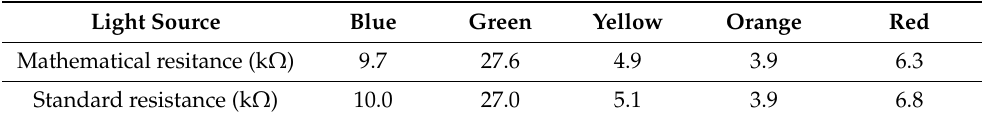
Table 4. Mathematical and standard resistance to fixed resistance in the voltage divider. Light Source Blue Green Yellow Orange Red Mathematical resitance (k Ω )